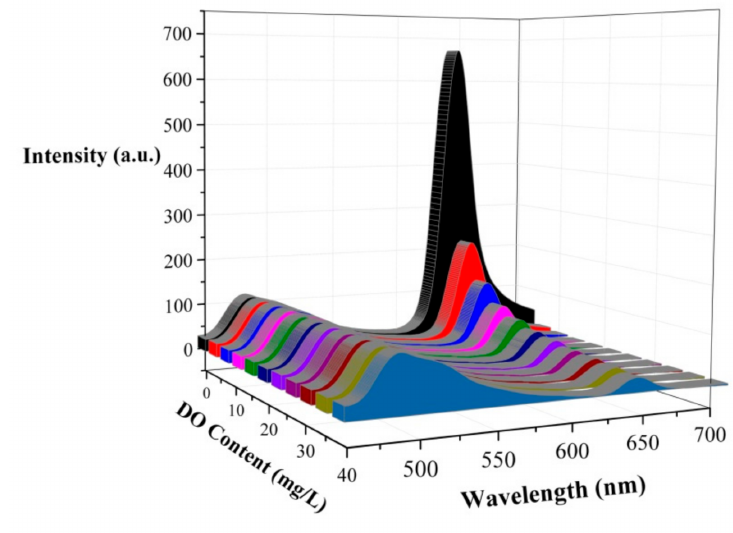
Figure 3. Variation in the luminescence intensity of the ratiometric sensing film with dissolved oxygen (DO) content.